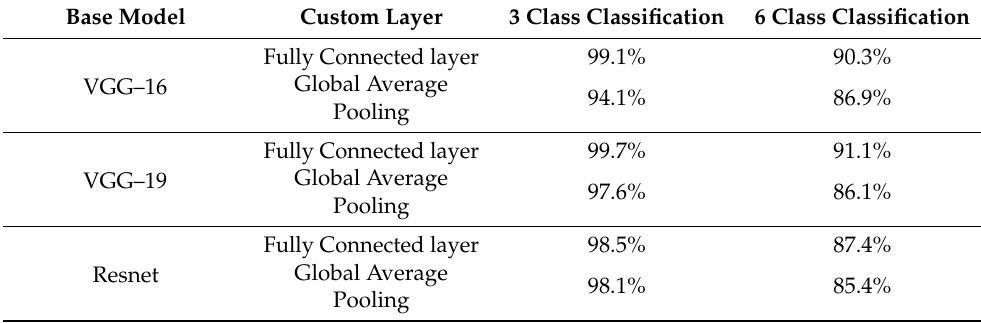
Table 2. Comparative results of CNN-based models (VGG–16, VGG–19, and ResNet).